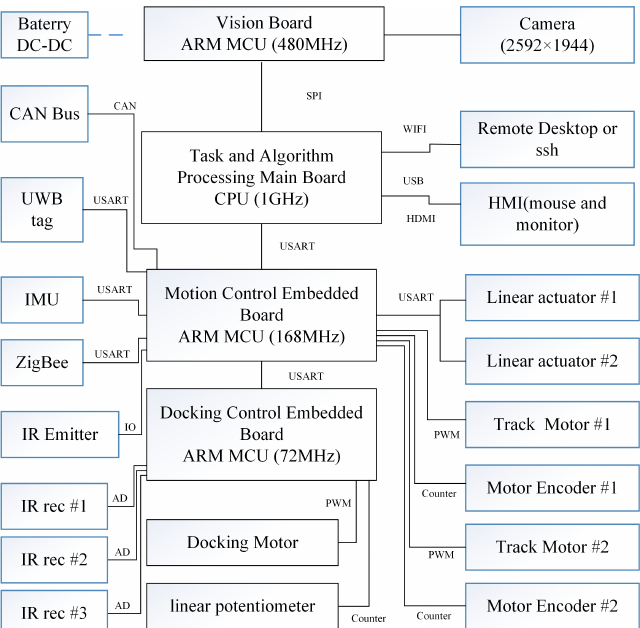
Figure 6. The hardware for sensing, control, communication, and localization, the communications between circuit boards and the main input/output